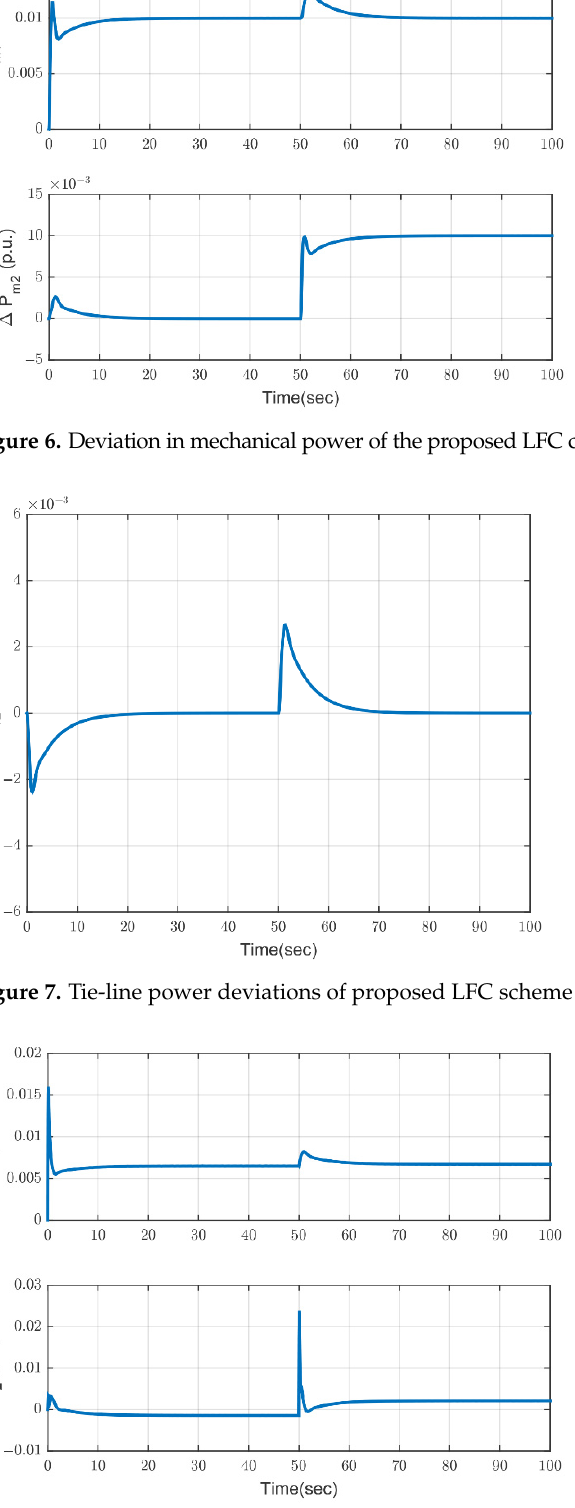
Figure 8. Control input for the unit step load disturbance.